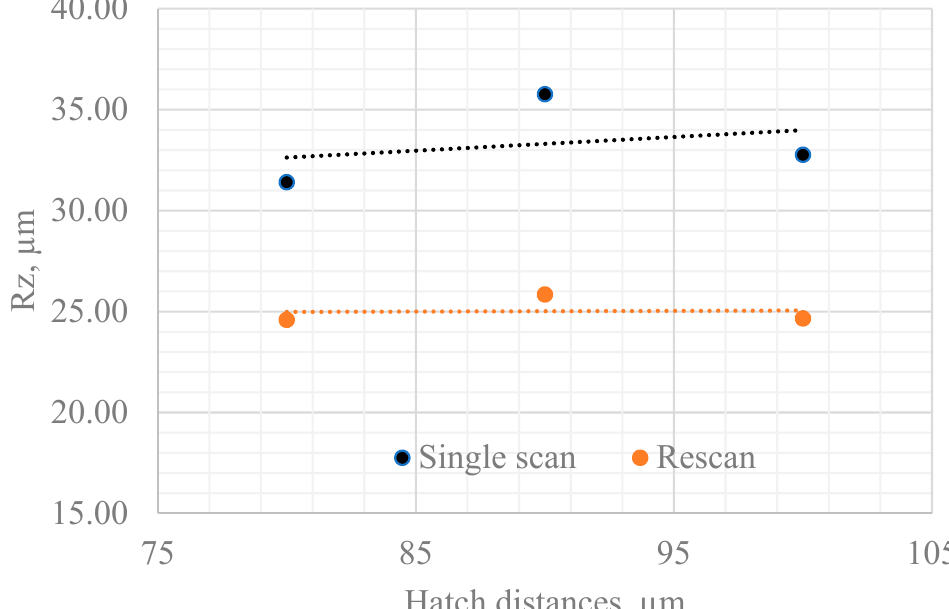
Figure 8. Surface roughness (Rz) of the sintered layers.